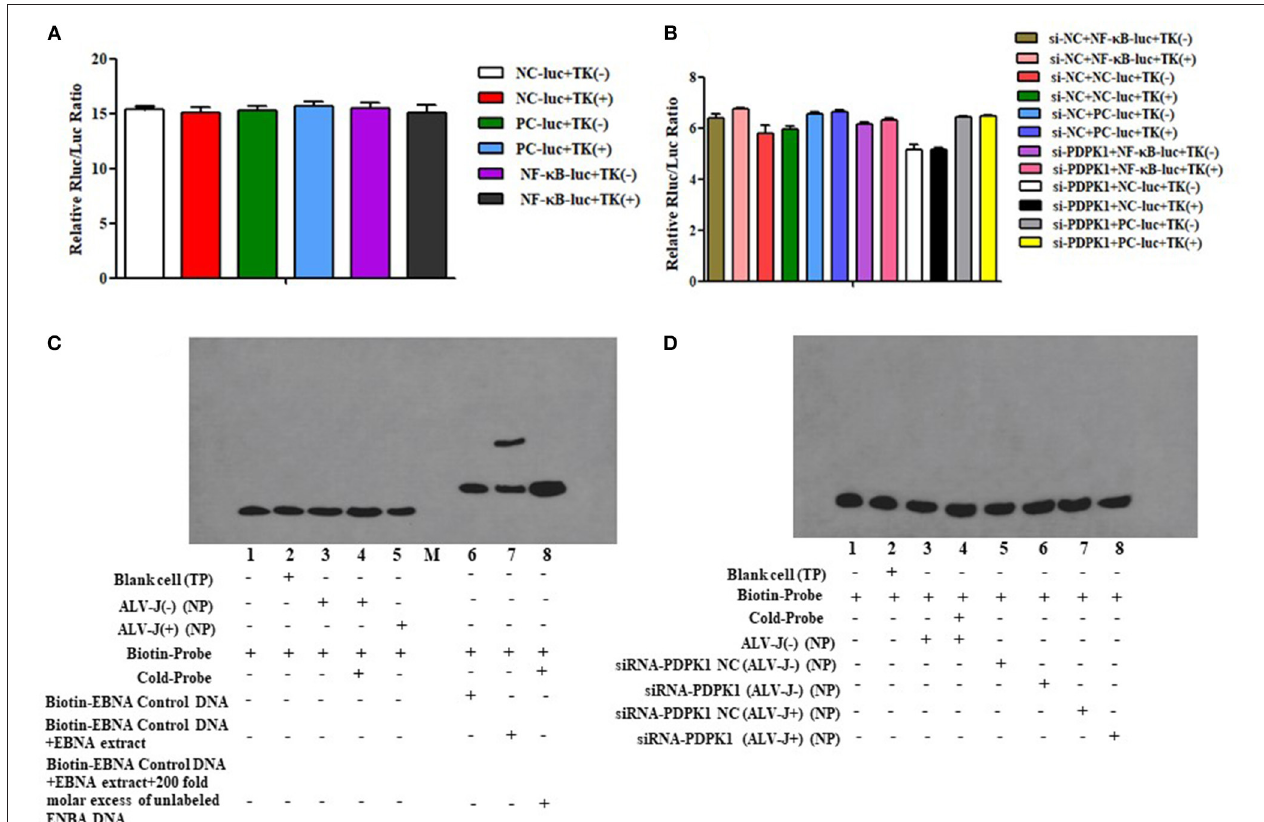
FIGURE 10 | The effect of knockdown of PDPK1 on NK- κ B activity of ALV-J-infected CEF cell. (A,B) The effect of ALV-J and knockdown of PDPK1 on NK- κ B activity of CEF cell using dual luciferase reporter gene test, respectively. (C,D) The effect of ALV-J and knockdown of PDPK1 on NK- κ B activity of CEF cell using EMSA,